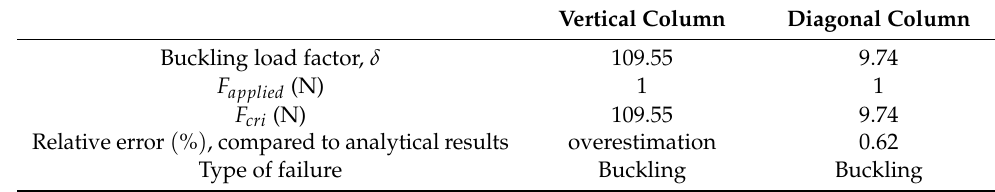
Table 2. Numerical buckling results for both column components.